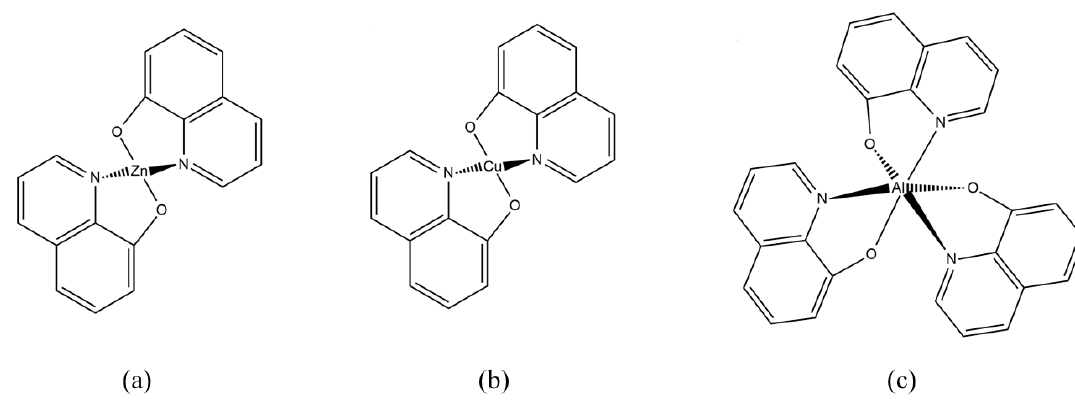
Figure 1. Chemical structures of investigated molecules: ( a ) 8-Hydroxyquinoline zinc [Znq 2 ], ( b ) 8-Hydroxyquinoline copper II [Cuq 2 ], ( c ) Tris(8-Hydroxyquinoline) aluminium [Alq 3 ].